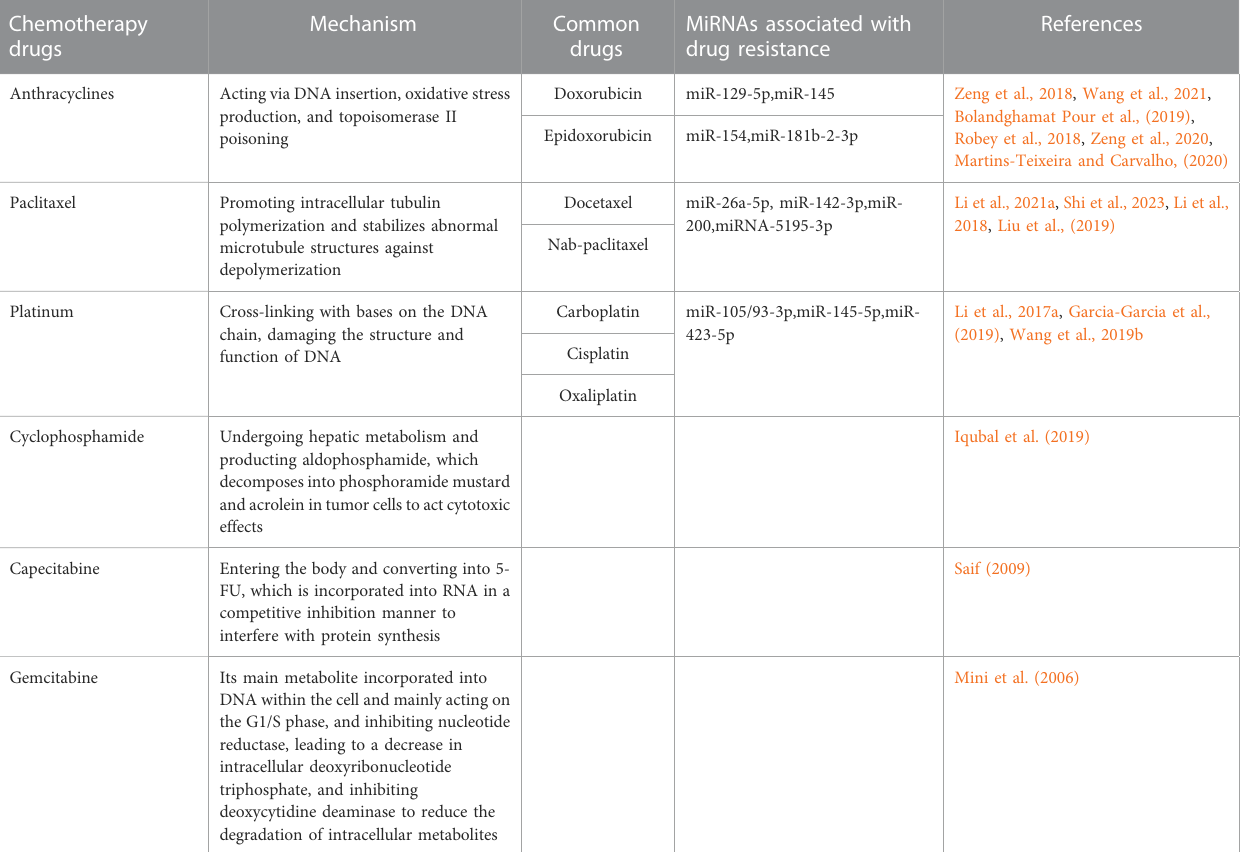
TABLE 4 Common chemotherapeutic drugs for